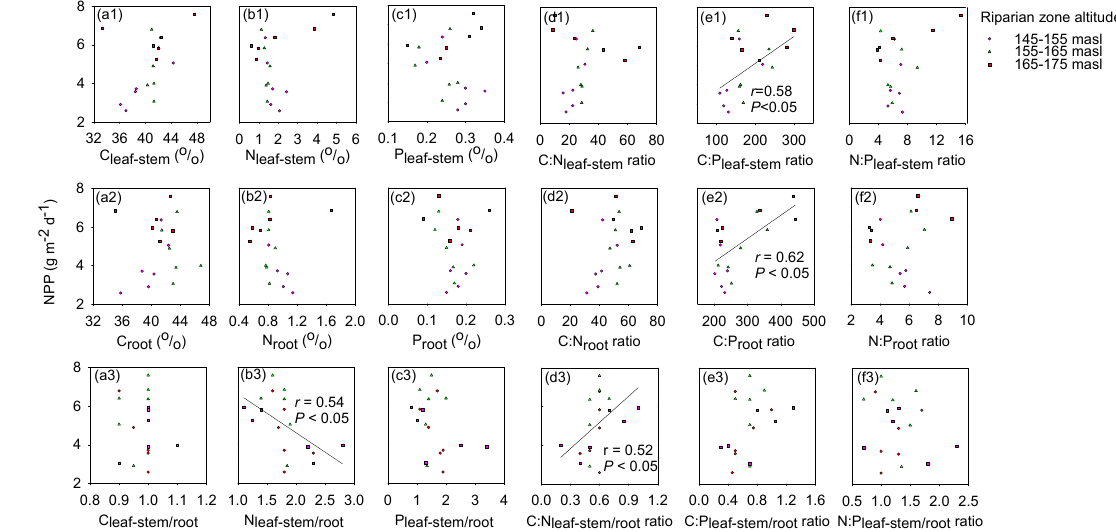
Figure 5. C:N:P stoichiometry with NPP . Leaf-stem: ( a1 – f1 ), Root: ( a2 – f2 ), leaf-stem/root: ( a3 – f3 ).